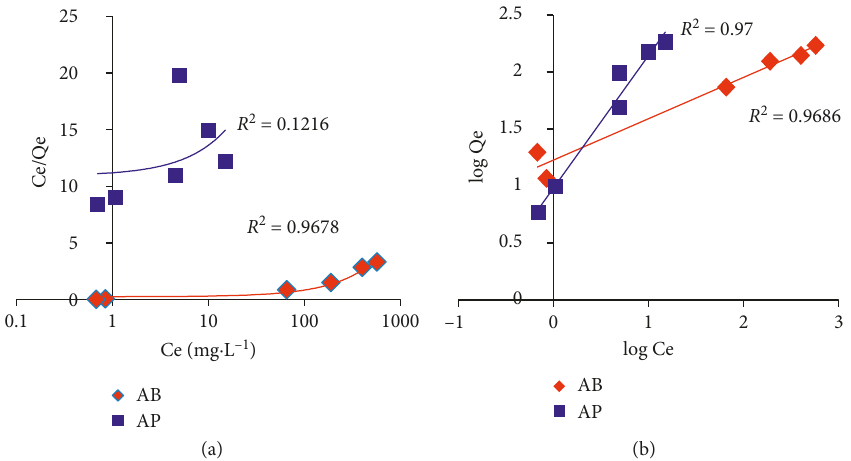
Figure 13: Adsorption isotherms according to Langmuir (a) and (b) Freundlich models of purified and crude clays. Table 4: Characteristic parameters of the Langmuir and Freundlich isotherms. Langmuir Freundlich